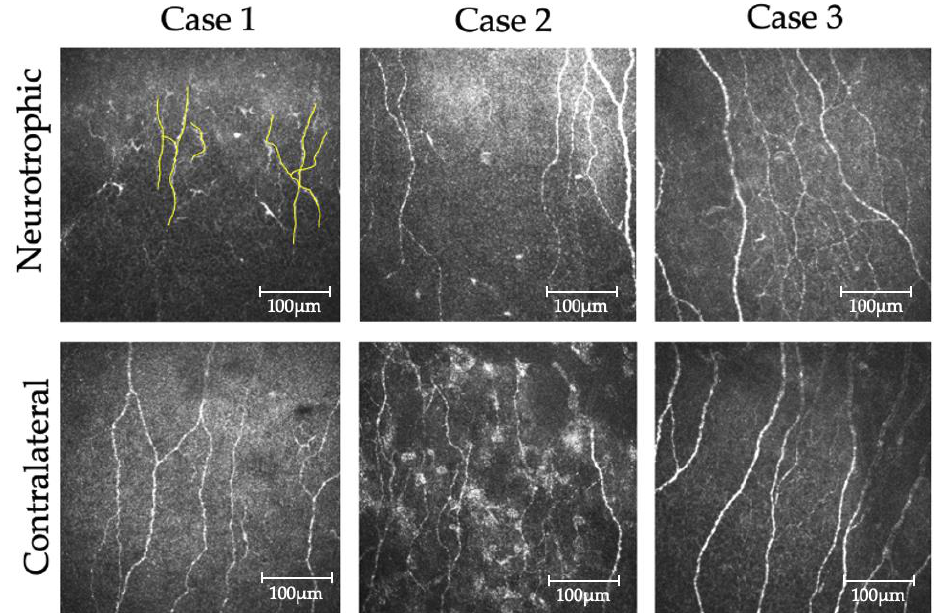
Figure 2. Sub-basal nerve plexus assessed by in vivo confocal microscopy. The upper panels show the neurotrophic cornea, and the lower panels show the contralateral cornea. We traced all nerve fibers (yellow line) and determined the mean density of the sub-basal nerve plexus using five photographs in each patient. Note that there was a significant decrease in nerve fiber density in the neurotrophic eye.